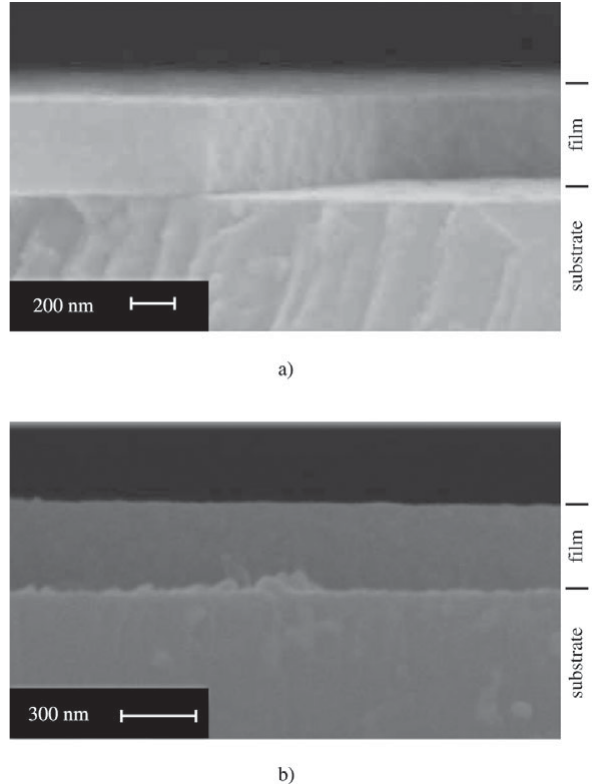
Figure 4. Scanning electron microscopy results to SnO produced by a) PI; b)